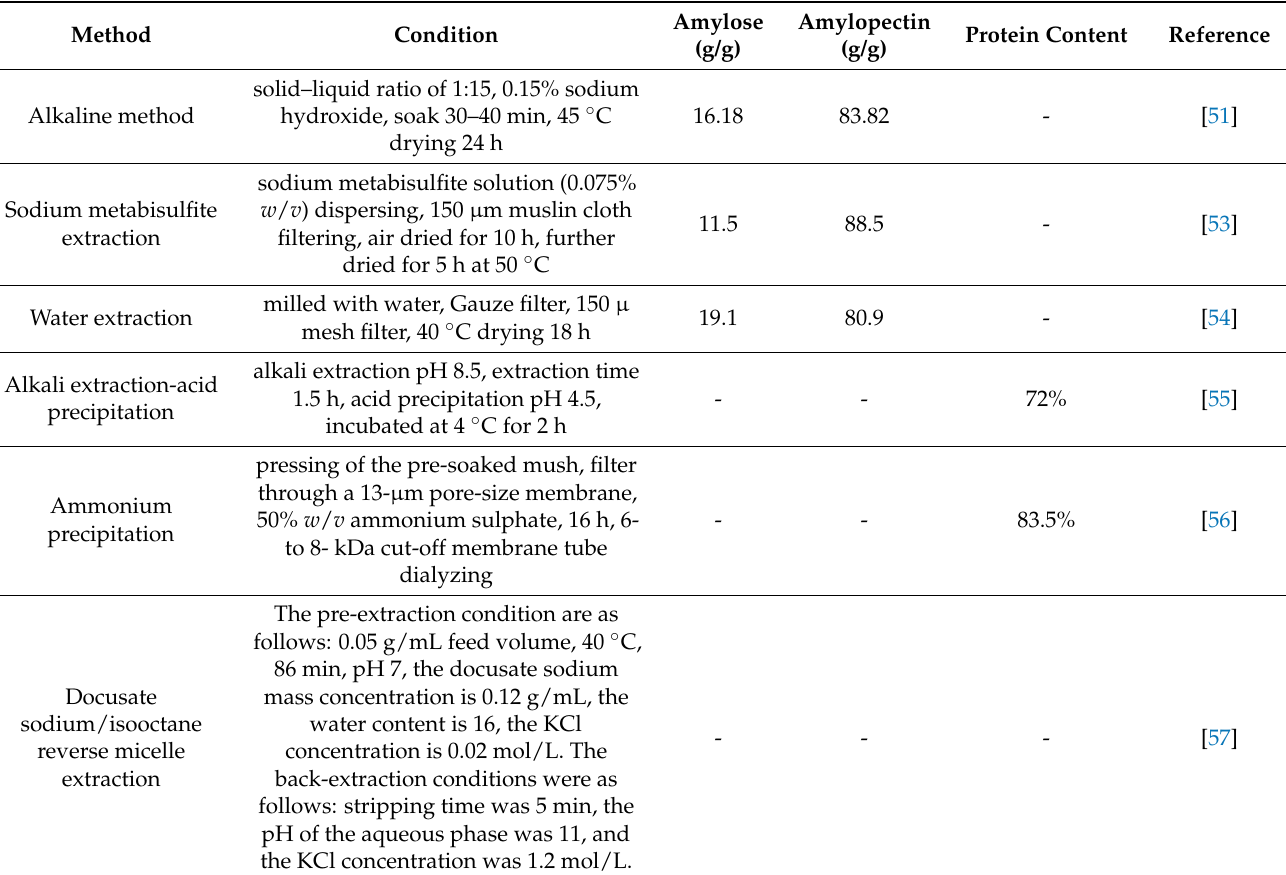
Table 4. Extraction technologies of tiger nut starch and